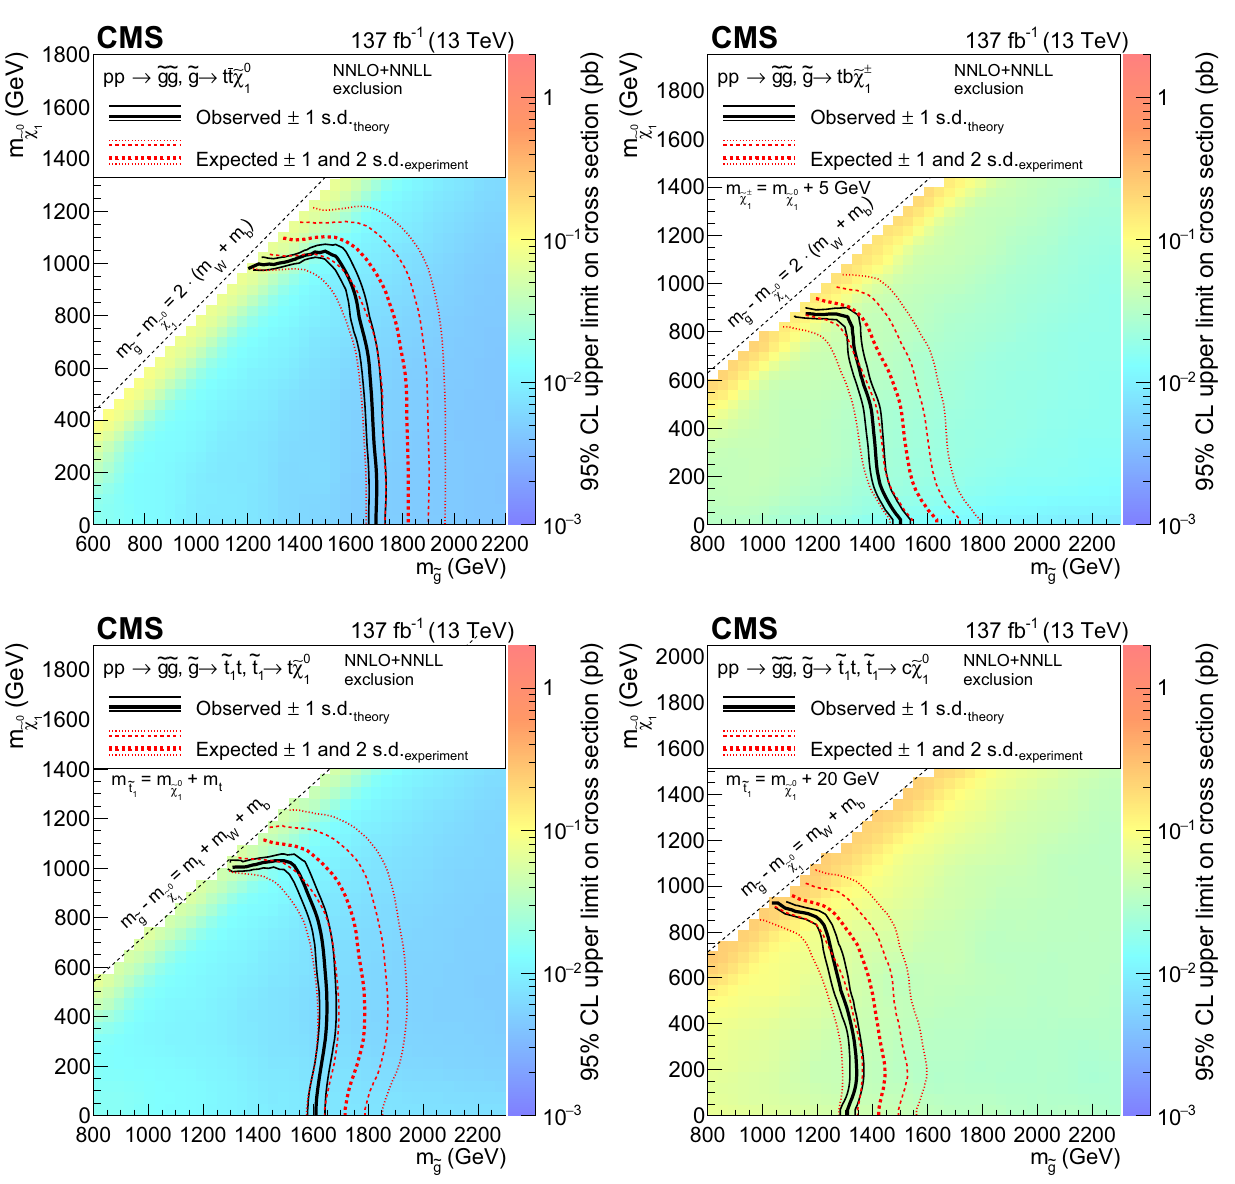
Fig. 7 Exclusion regions at 95% CL in the m ˜ χ 0 versus m ˜ g plane for scale indicates the excluded cross section values for a given point in the 1 SUSYparticlemassplane.Thesolidblackcurvesrepresenttheobserved the T1tttt (upper left) and T5ttbbWW (upper right) models, with off- exclusion limits assuming the approximate-NNLO+NNLL cross sec- shell third-generation squarks, and the T5tttt (lower left) and T5ttcc tions [46–51,58] (thick line), or their variations of ± 1 standard devia- (lower right) models, with on-shell third-generation squarks. For the = m + 5GeV, for the T5tttt model, tions (s.d.) (thin lines). The dashed red curves show the expected limits T5ttbbWW model, m ˜ χ ± ˜ χ 0 1 1 with the corresponding ± 1 s.d. and ± 2 s.d. uncertainties. Excluded − m = m − m = 20GeV m ˜ ˜ χ 0 ˜ χ 0 t , and for the T5ttcc model, m ˜ t t regions are to the left and below the limit 1 1 . The right-hand side color and the decay proceeds through ˜ t → c ˜ χ 0 1